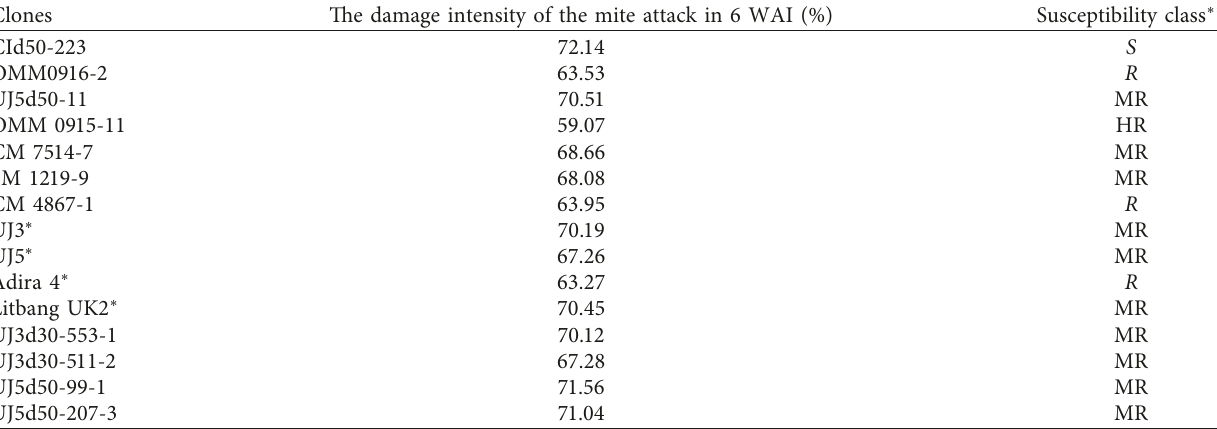
Table 5: The damage intensity of mite attack and susceptibility class of promising clones, glass house, 2018. Clones